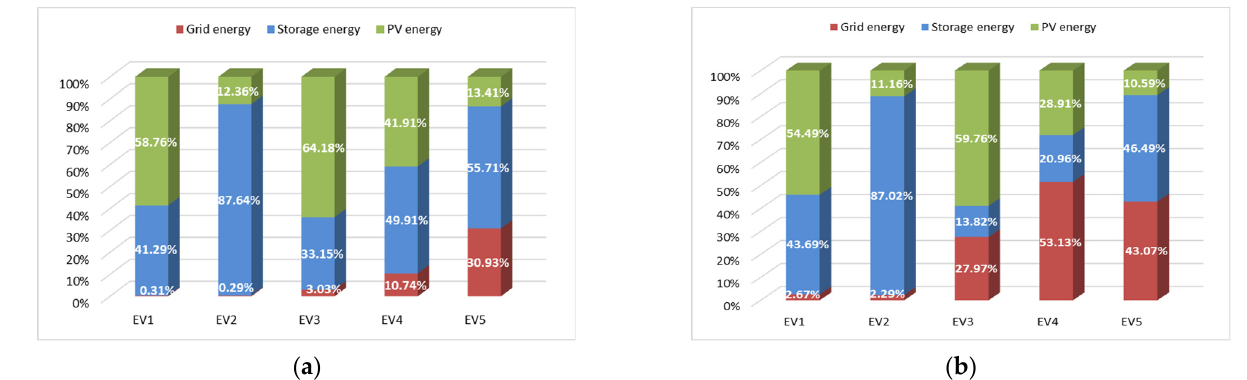
Figure 22. EV energy distribution for “real-time exp” ( a ) without opt and ( b ) with opt—experimental test 1.